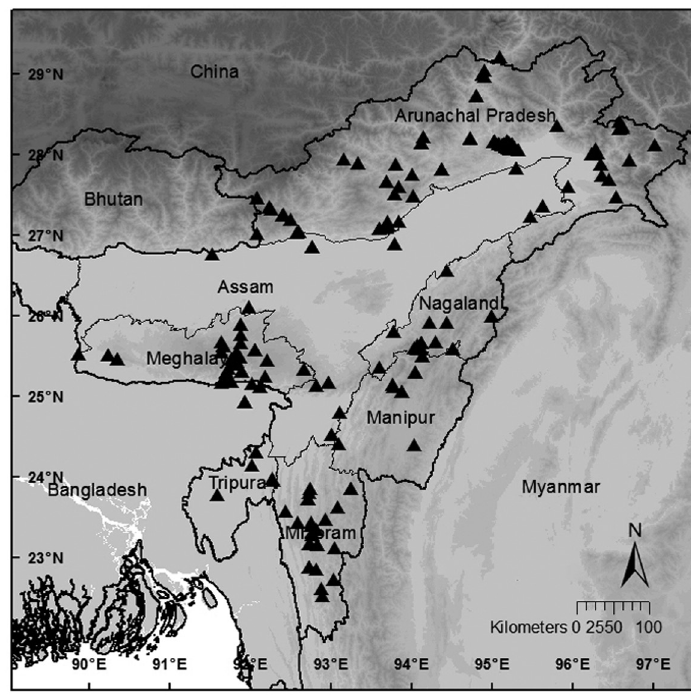
Fig. 1. Map showing the collection sites of Begonia specimens from the study area. Locations may represent the nearest village or town and not the exact